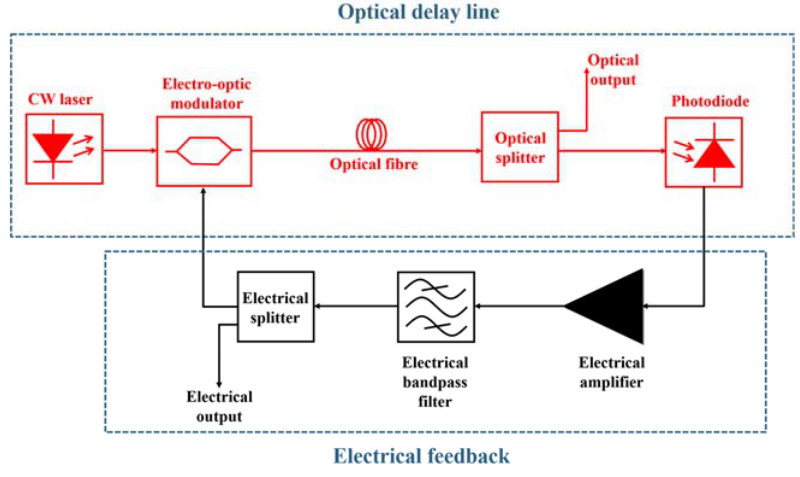
Figure 1. Single-loop opto-electronic oscillator (OEO) with electrical components.